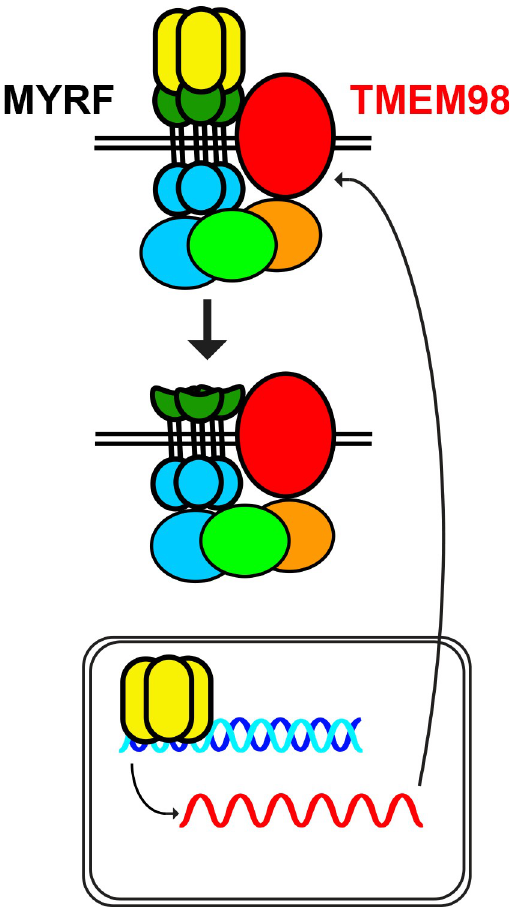
Fig 10. Model of MYRF and TMEM98 function. MYRF interacts with TMEM98 and other factors, as yet unidentified, and upon cleavage activates transcription of specific downstream genes, including TMEM98, in various tissues including RPE. MYRF domains including the N-terminal (yellow), intramolecular chaperone (green), and C- terminal (blue) domains are highlighted.